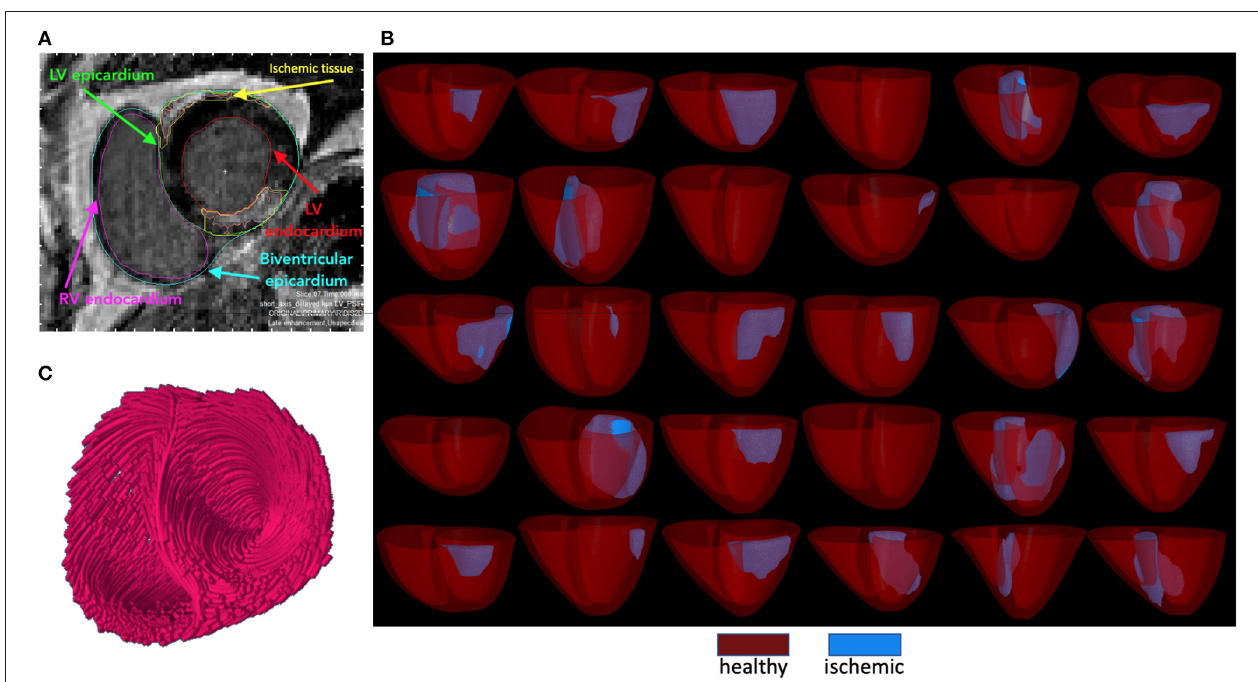
FIGURE 1 | (A) Patient MRI and segmentation of endocardial, epicardial, and ischemic surfaces. (B) Rule-based fiber orientation. (C) The generated 30 baseline geometries with ventricles rendered semi-transparently.